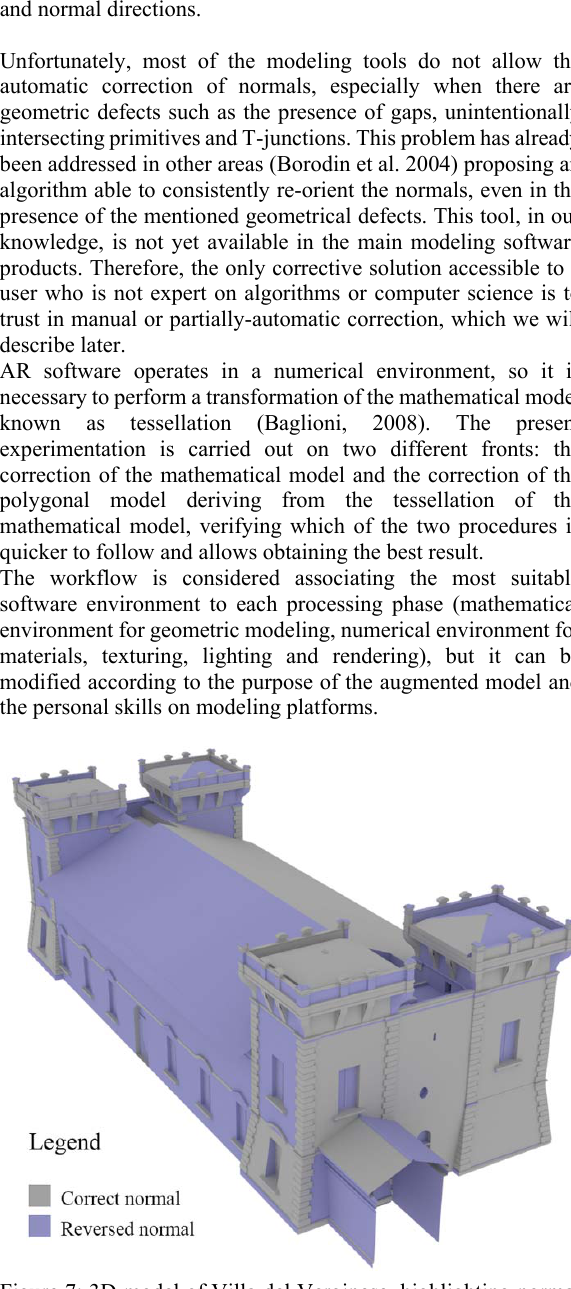
Figure 7: 3D model of Villa del Verginese, highlighting normal surface distribution. Figure 8: Final AR of Villa del Verginese, developed in Unity with Vuforia